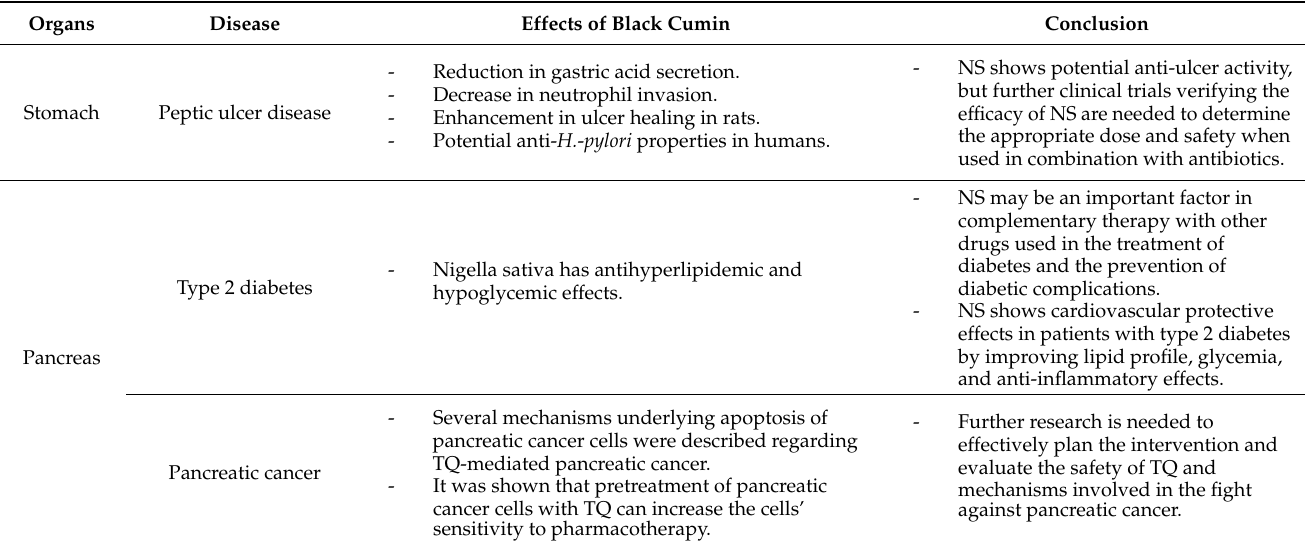
Table 1. Summary of the effect of Nigella Sativa on gastrointestinal